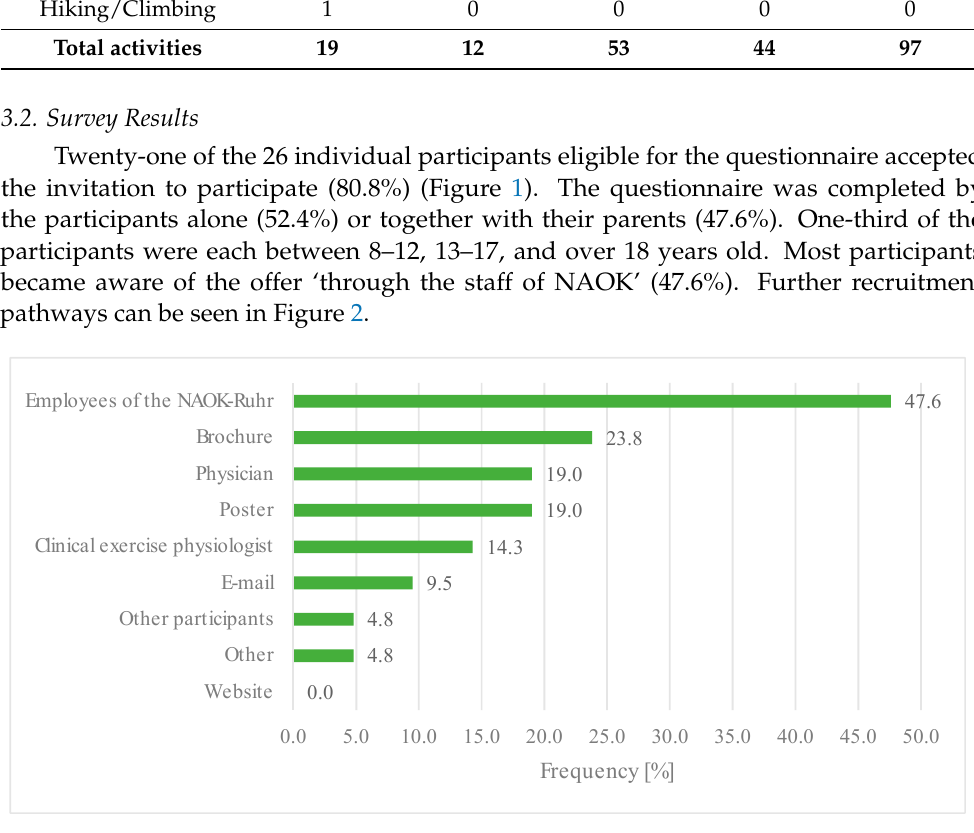
Figure 2. Recruitment ways of participants for the outdoor exercise program.